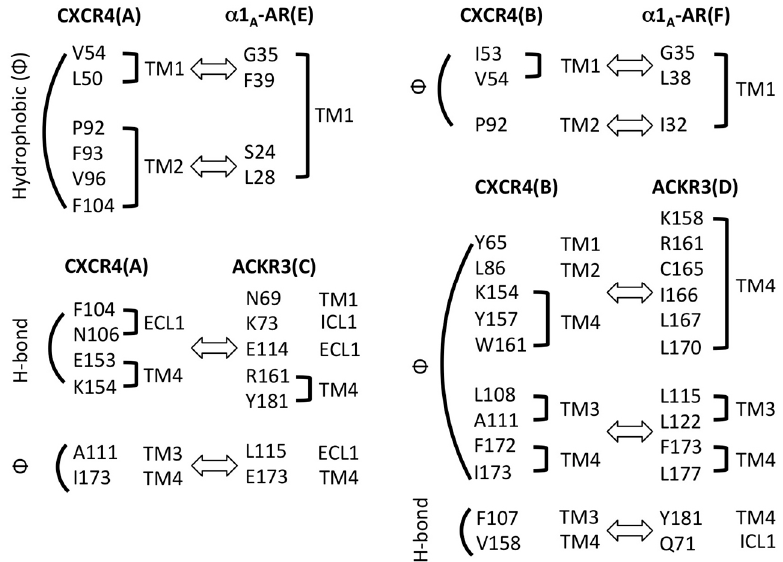
Figure 7. Contacts between CXCR4 and modeled receptors based on Figure 6. Receptor pairs are indicated in bold font. Hydrophobic and hydrogen (H)-bond interactions are grouped and indicated on the left side of each pair. Secondary structural location of each residue is indicated on the right side. Inter-receptor interactions are indicated with a block arrow.